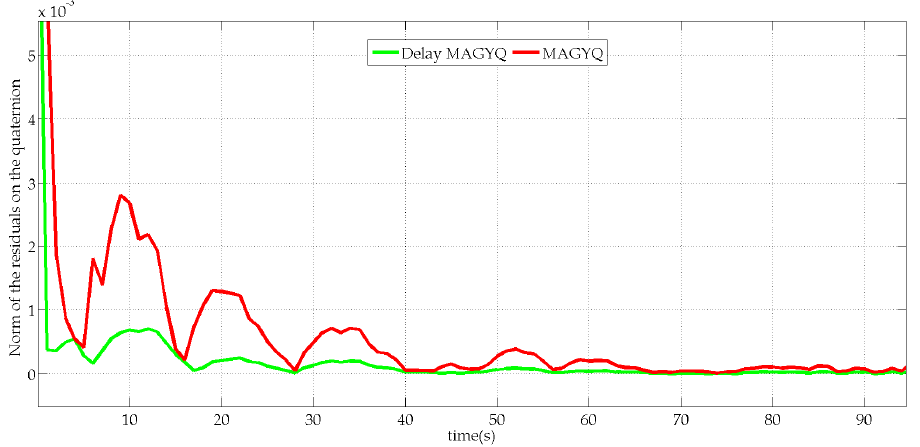
Figure 10. Norm of the residual errors ( K δ z ) on the quaternion orientation estimated with MAGYQ (red) and Delay-MAGYQ (green).